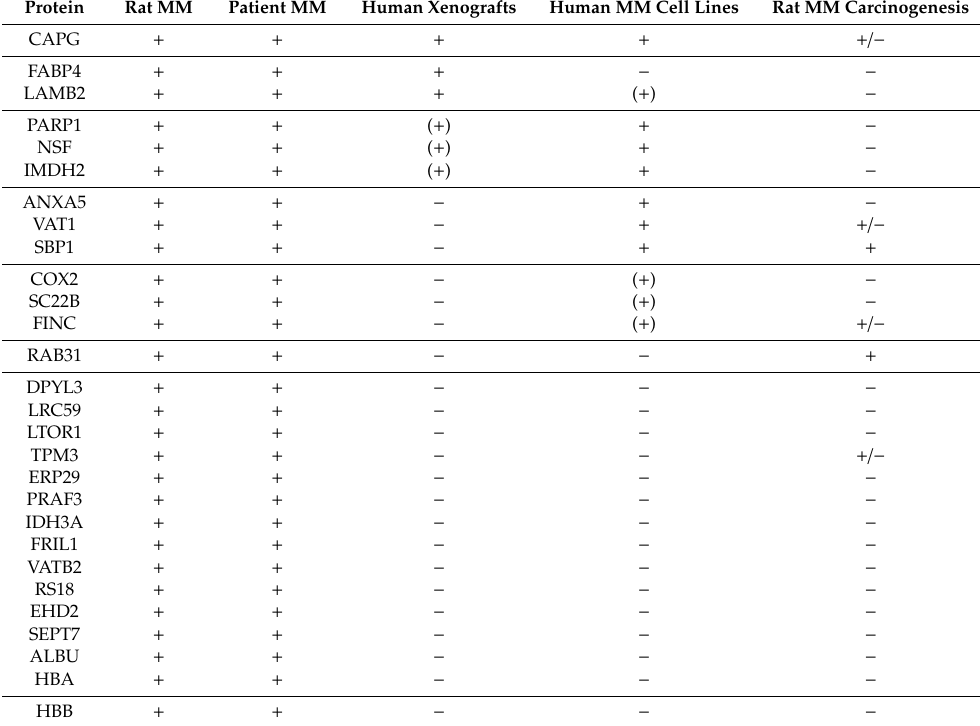
Table1. SummaryofproteomicsbiomarkersofMMinvasivenessandcarcinogenesis.